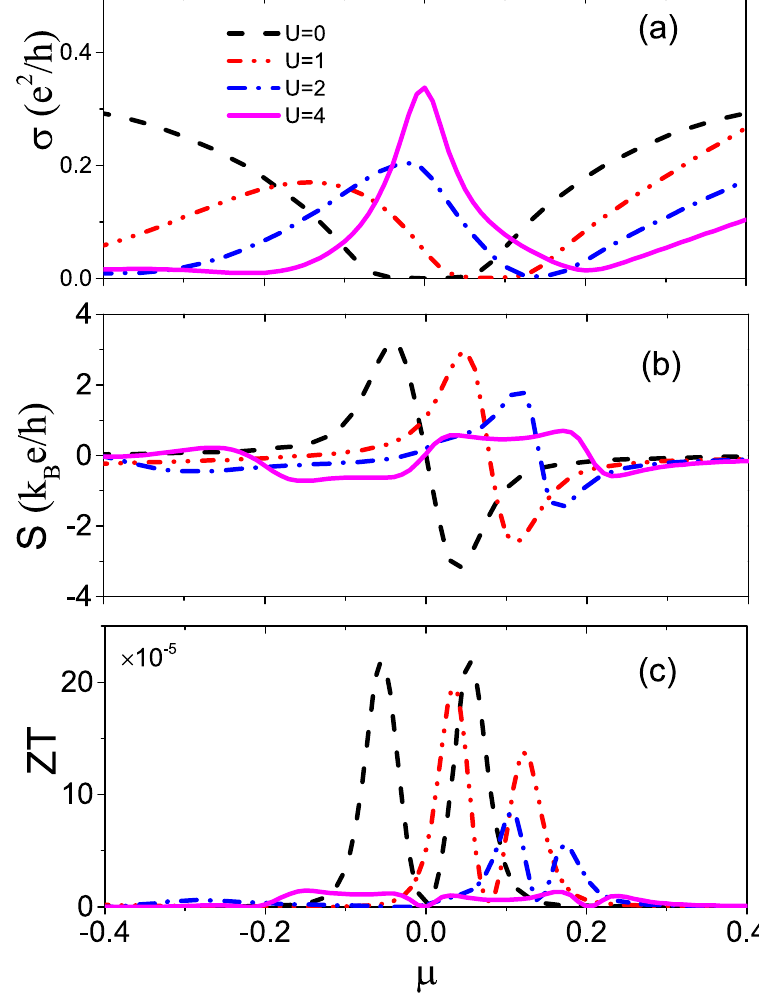
Figure 5. ( a – c ) The electric conductivity σ , the thermopower S , and the figure of merit ZT as a function of μ for U = 0, 1, 2, 4. We chose M = 0.8 and the other parameters are the same as in Fig.